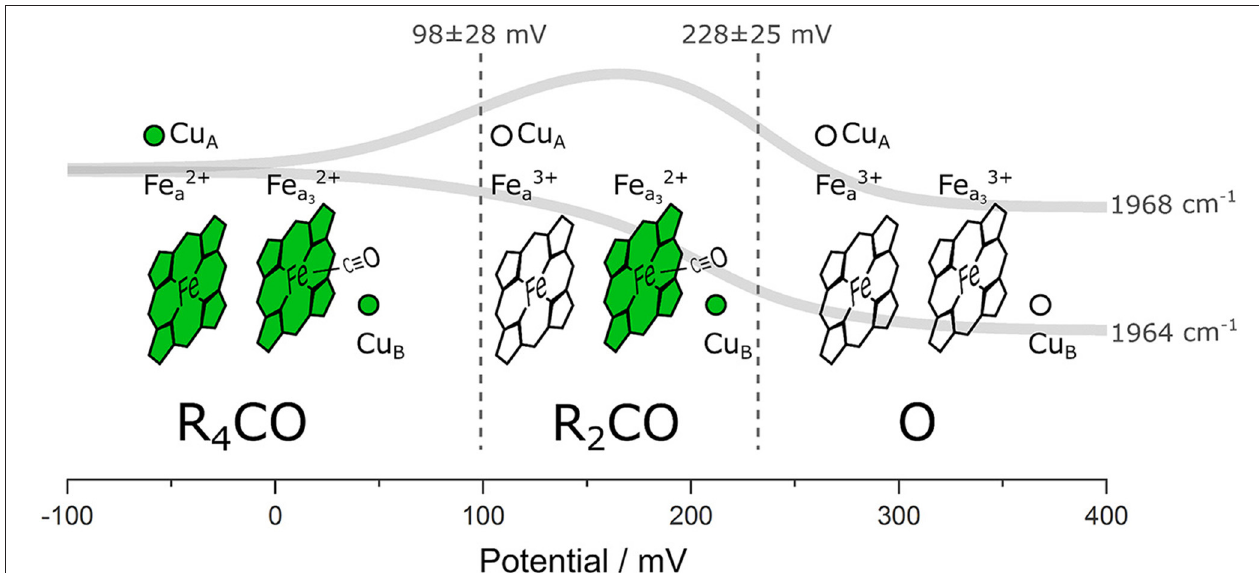
FIGURE 5 | Schematic representation of the different C c O states distinguishable in our experiment. The four redox-active metal cofactors are figuratively depicted as reduced (green) or oxidized (transparent). The CO probe is shown in its bound states, and the global fit of the potential-dependent CO band intensity is shown as solid gray traces. Dashed vertical lines correspond to the midpoint potentials of the redox transitions. The identified states are labeled according to the nomenclature used in this work. The potential values are given against the Ag/AgCl reference